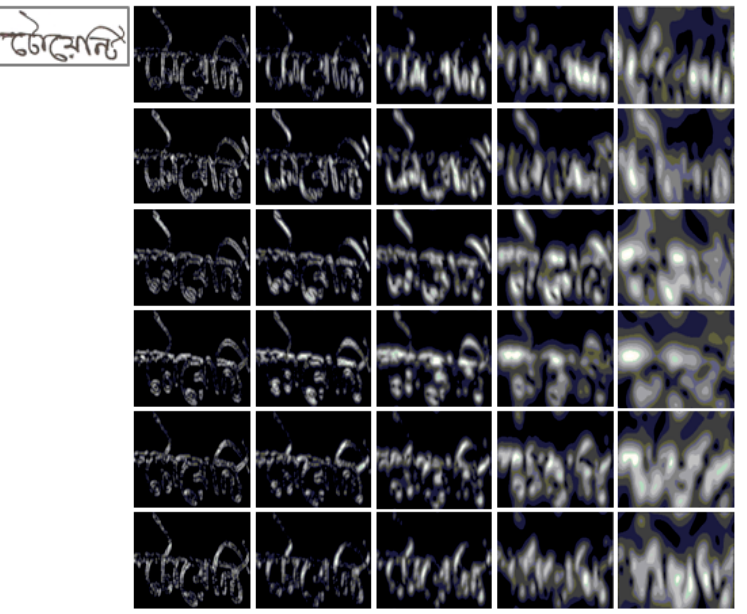
Figure 5. Output word images of Modified log-Gabor filter transform on a sample handwritten Bangla word image (shown on left-side) for 5 different scales and 6 different orientations (the first row shows the output for n o = 0 0 and five scales, the second row shows the output for n o = 30 0 and five scales and so on).